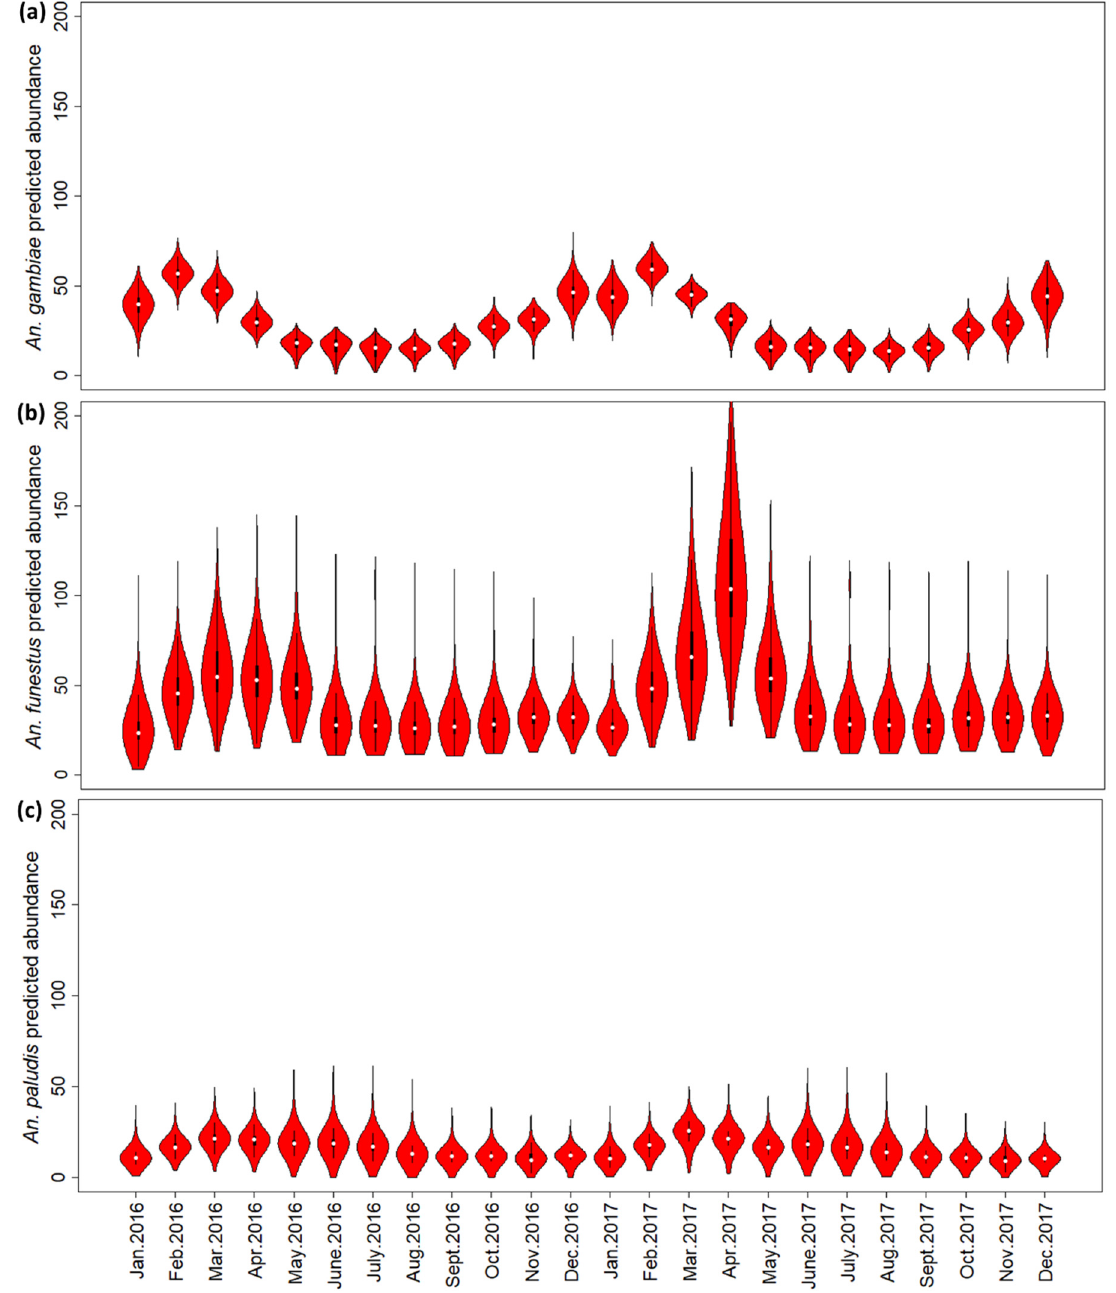
Figure 11. Violin plot displaying the distribution of mosquito abundances for all buildings of Ka- polowe for ( a ) An. gambiae s.l. ; ( b ) An. funestus; and ( c ) An. paludis